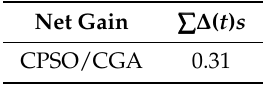
Table 9. Total net gain in time achieved by the proposed algorithm compared with the literature for Case II.